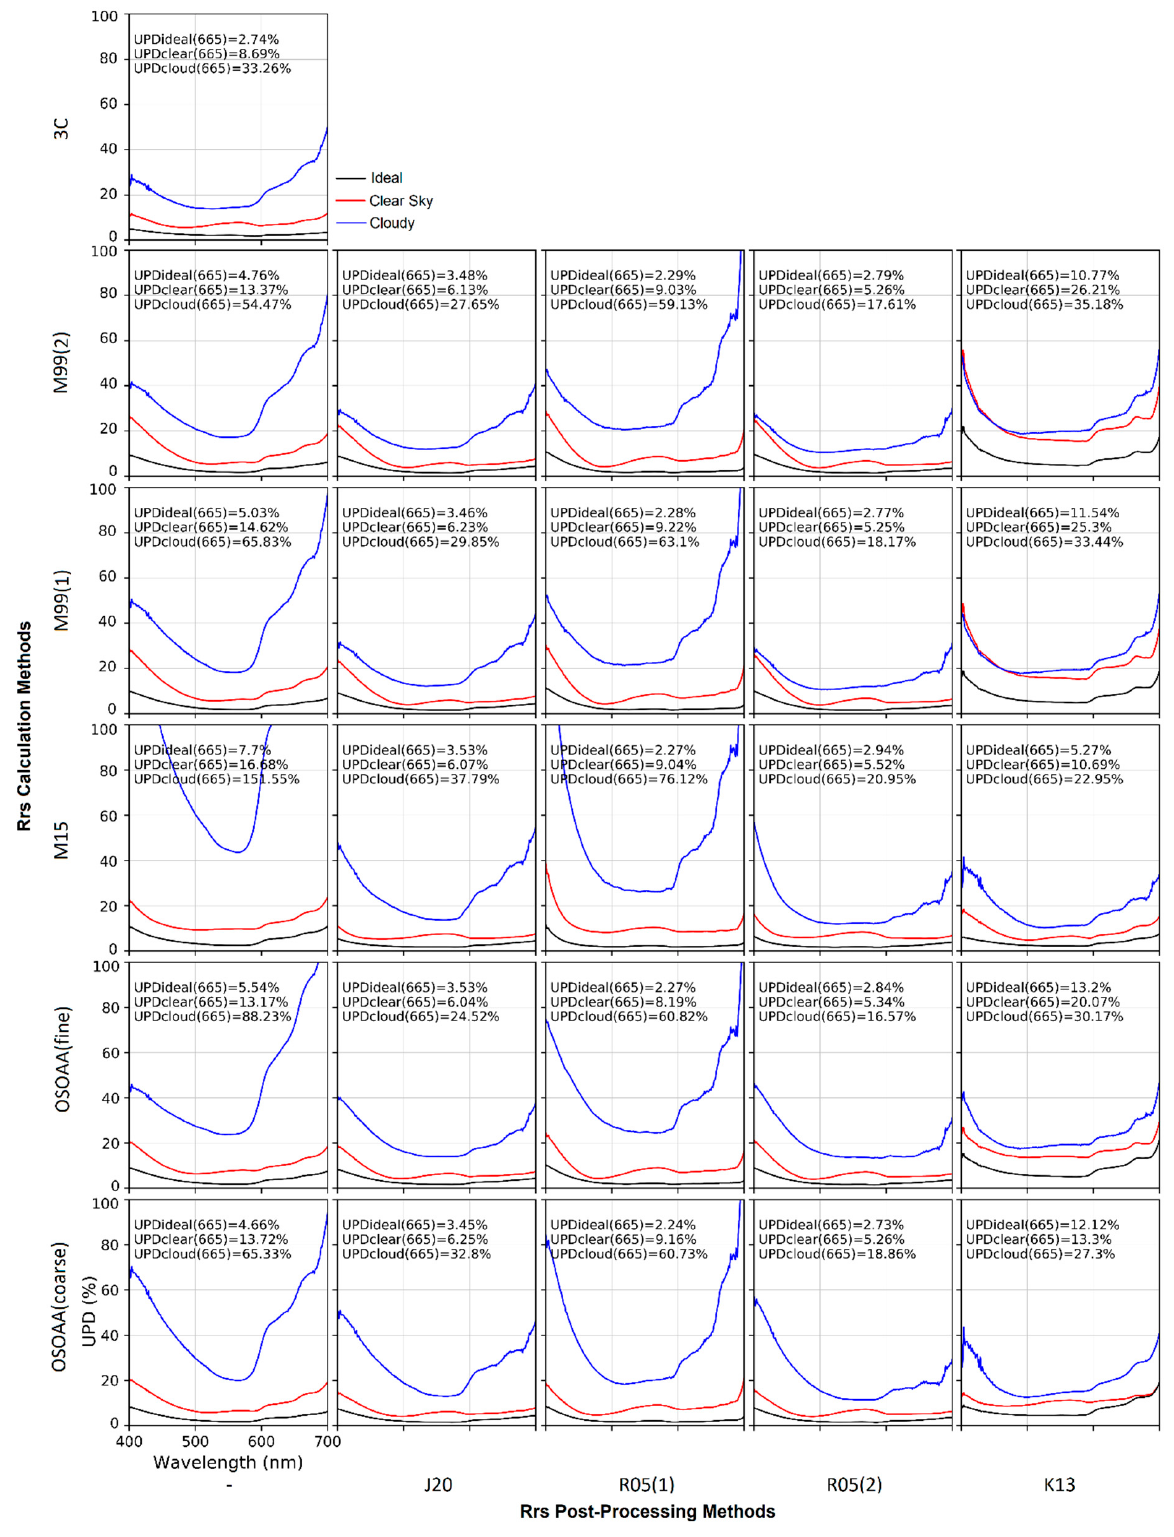
Figure 7. Each column corresponds to an R rs postprocessing method, whereas each row corresponds to an R rs calculation method. As such, each panel shows UPD(%) values of wavelengths in the 400–700 range for different model combinations and for different sky conditions (clear, cloudy, and ideal).